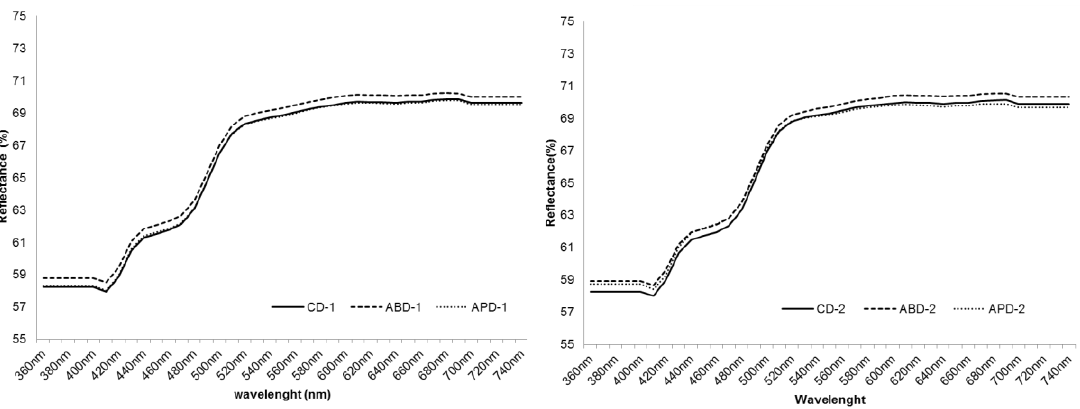
Figure 1. Reflectancies (360–740 nm) of milk from Murciano-Granadina goats fed on diets containing or not containing artichoke by-products (plant and outer bracts) in Experiment 1 (12.5% inclusion) and Experiment 2 (25% inclusion). CD-1: control diet in Experiment 1; ABD-1: artichoke bracts diet in Experiment 1; APD-1: artichoke plant diet in Experiment 1; CD-2: control diet in Experiment 2; ABD-2: artichoke bracts diet in Experiment 2; APD-2: artichoke plant diet in Experiment 2.